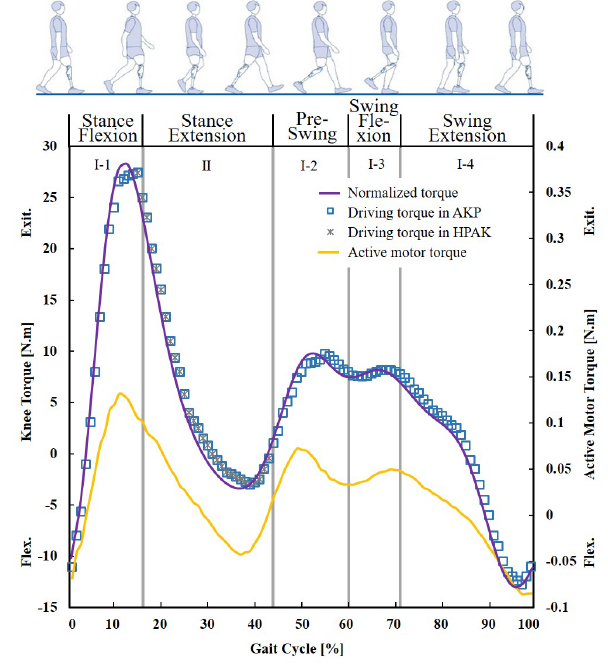
Figure 13. Torque response of active motor unit during ground walking.